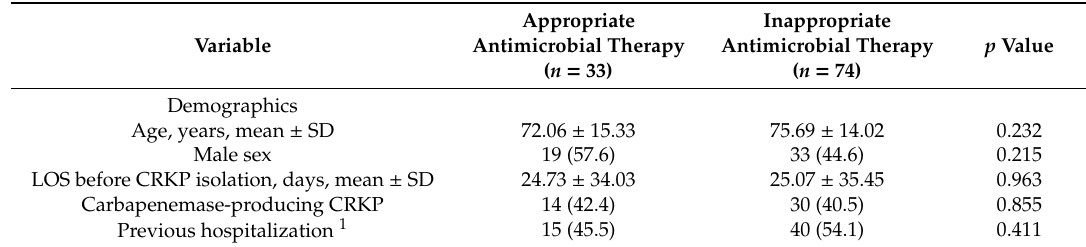
Table 1. Comparison of characteristics and outcomes of patients receiving appropriate antimicrobial therapy and those receiving inappropriate antimicrobial